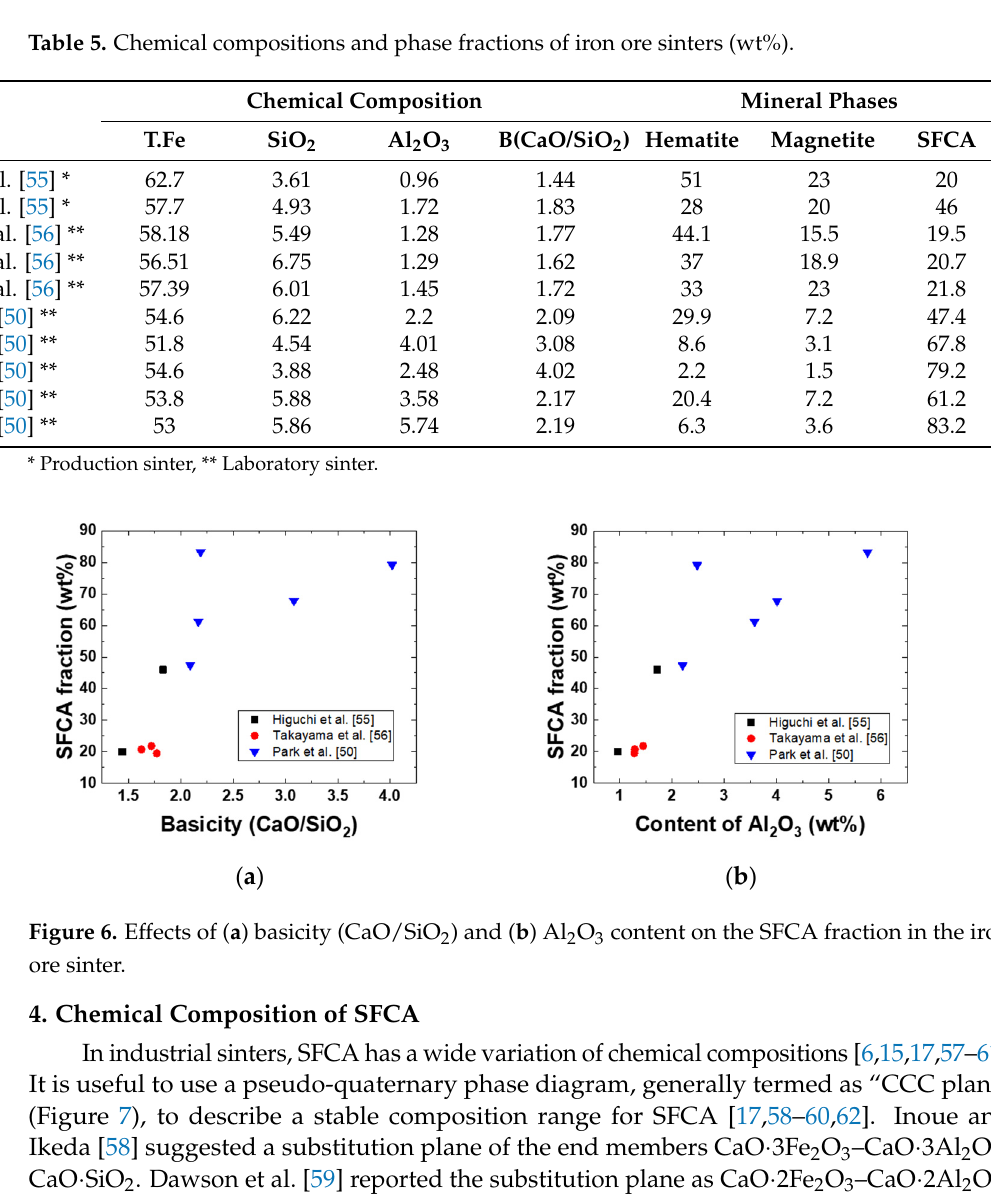
Figure 7. Previously proposed compositional planes for SFCA in the Fe 2 O 3 –Al 2 O 3 –CaO–SiO 2 system. The shaded area shows the SFCA compositions in industrial iron ore sinters [62].